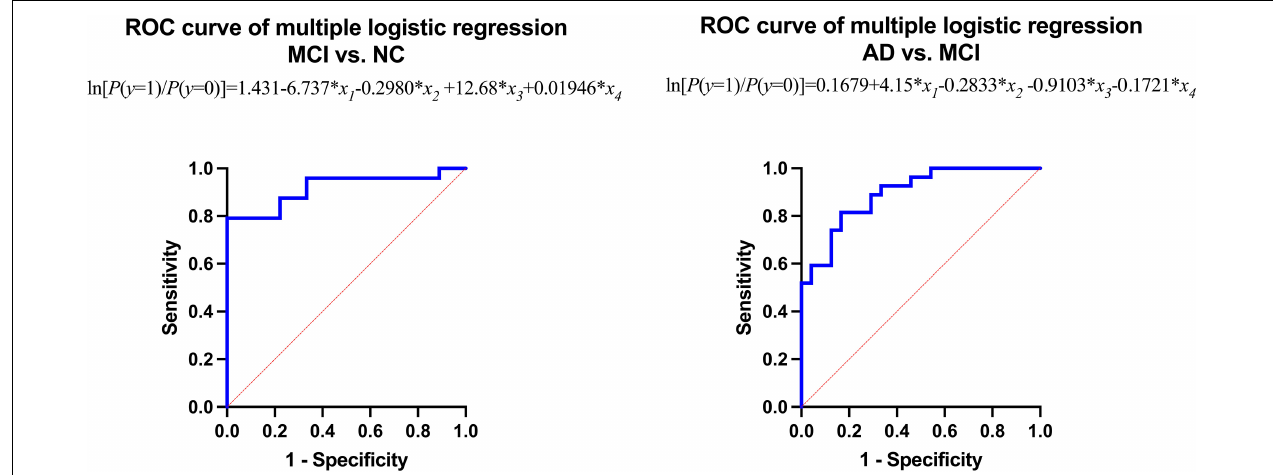
FIGURE 4 | Receiver operating characteristic (ROC) curve of multiple logistic